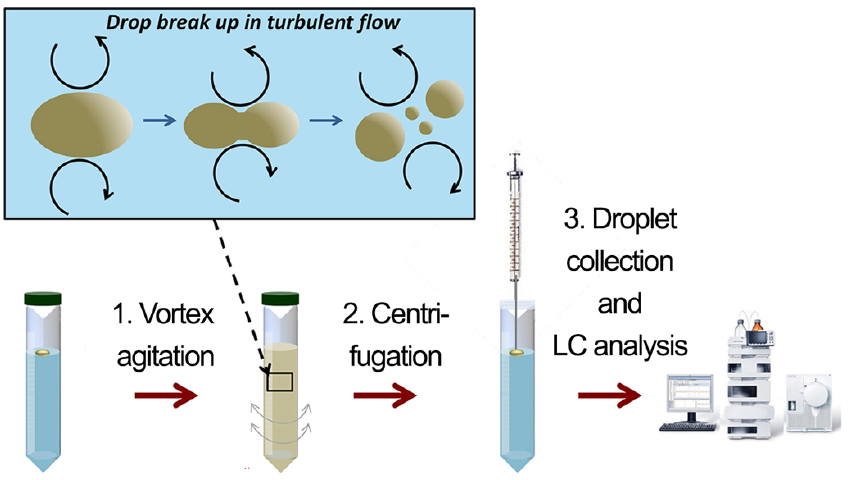
Figure 2. VALLME workflow (adapted from [45]). (Reprint with permission from [45], Copyright (2019) ELSEVIER).